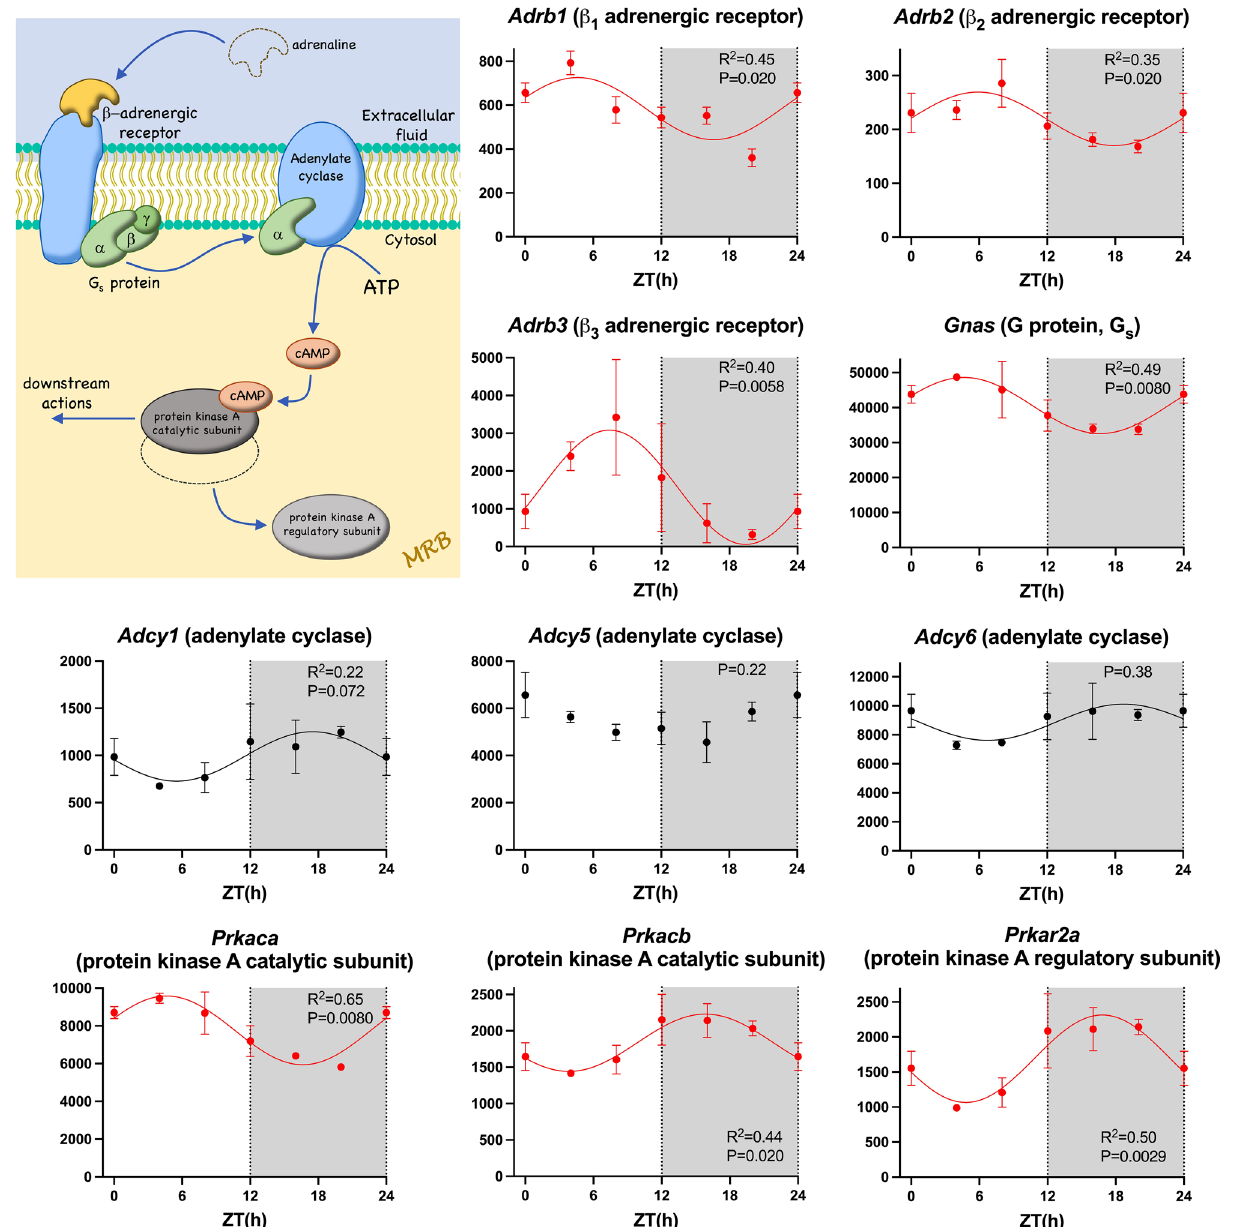
Figure 4. β-adrenergic receptor pathway. Abundance (normalised counts) of β-adrenergic receptor pathway transcripts is shown over 24 h. The inset shows a schematic diagram of the β-adrenergic receptor pathway. Transcripts for two other protein kinase A subunits, Prkar1b and Prkar2b , also showed a significant circadian rhythm (data not shown). See Fig. 1 legend for further